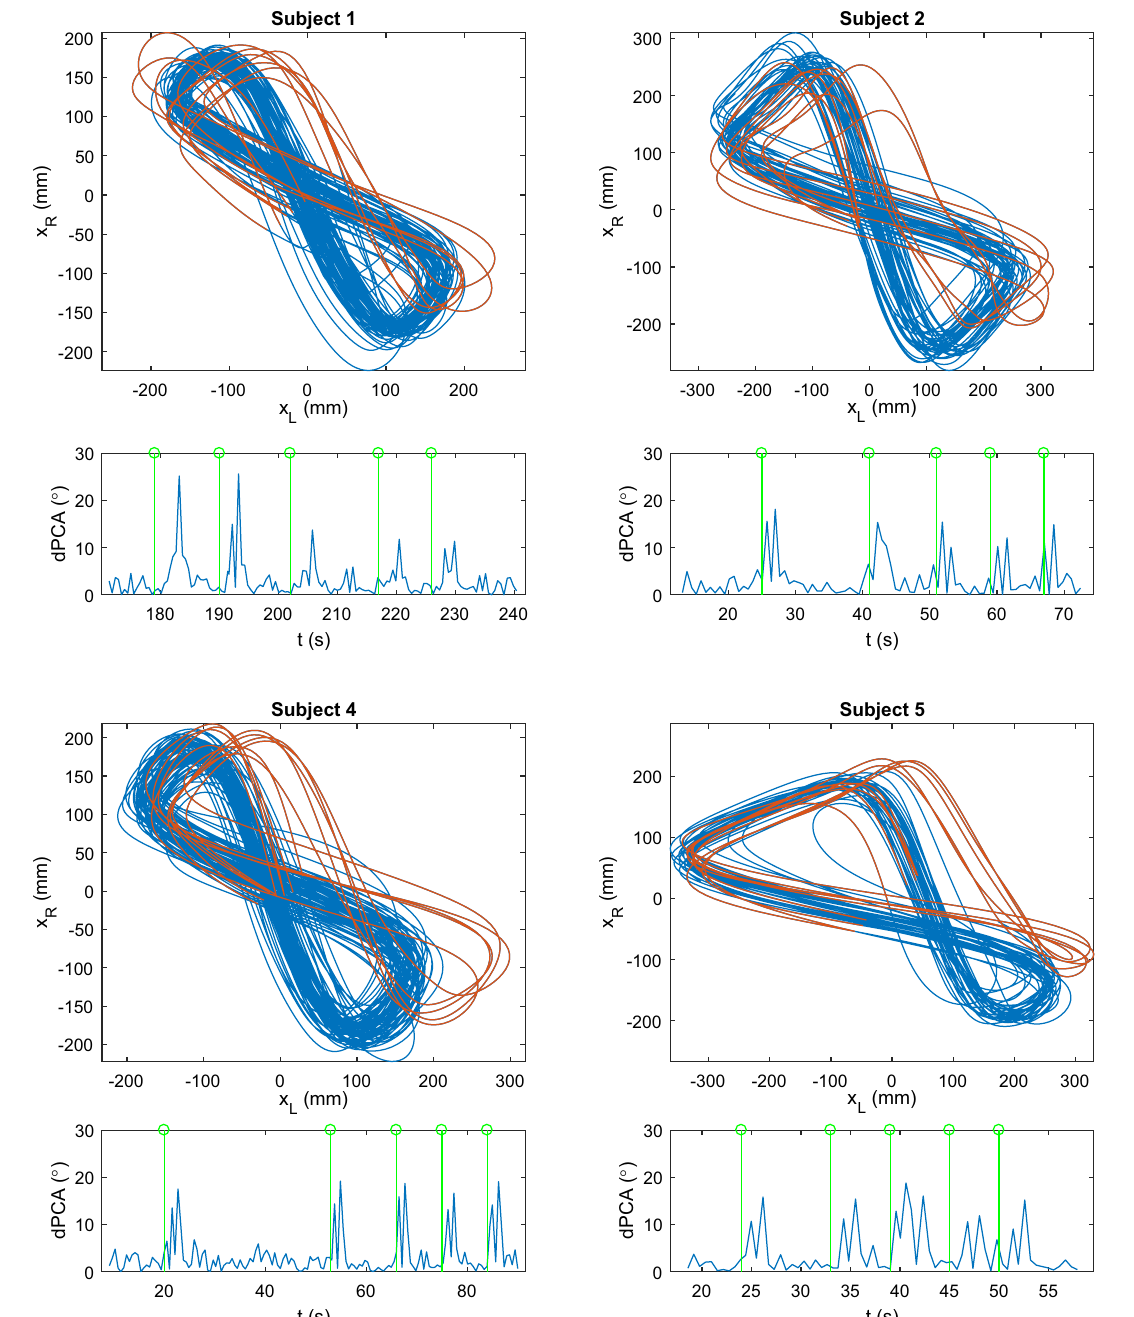
Figure 5. Feet spatial trajectory of four subjects walking on level-ground, interleaved with sidesteps. The angle between the principal components of the consecutive trajectories, dPCA, below the feet spatial trajectory, with the green lines corresponding to the time the sound signal is given to command the sidestep. The high dPCA values correspond to the sidestep discrete event (orange orbits), which disrupts the normal walking pattern (blue